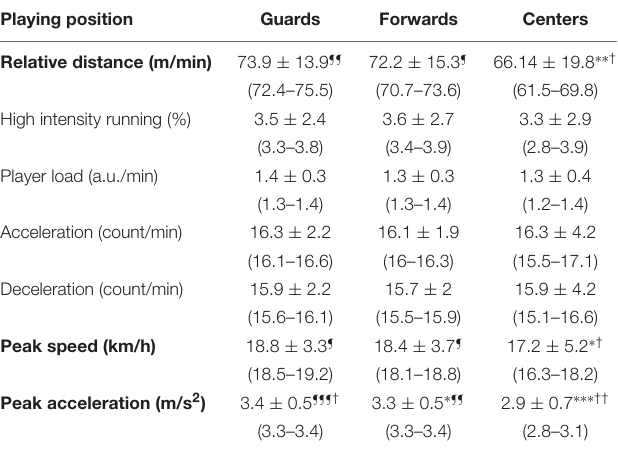
TABLE 4 | Means ± SDs, 95% Cis (in parentheses), one-way ANOVA and pair-wise comparisons with Cohen’s effect sizes (d) of basketball kinematic studied variables per